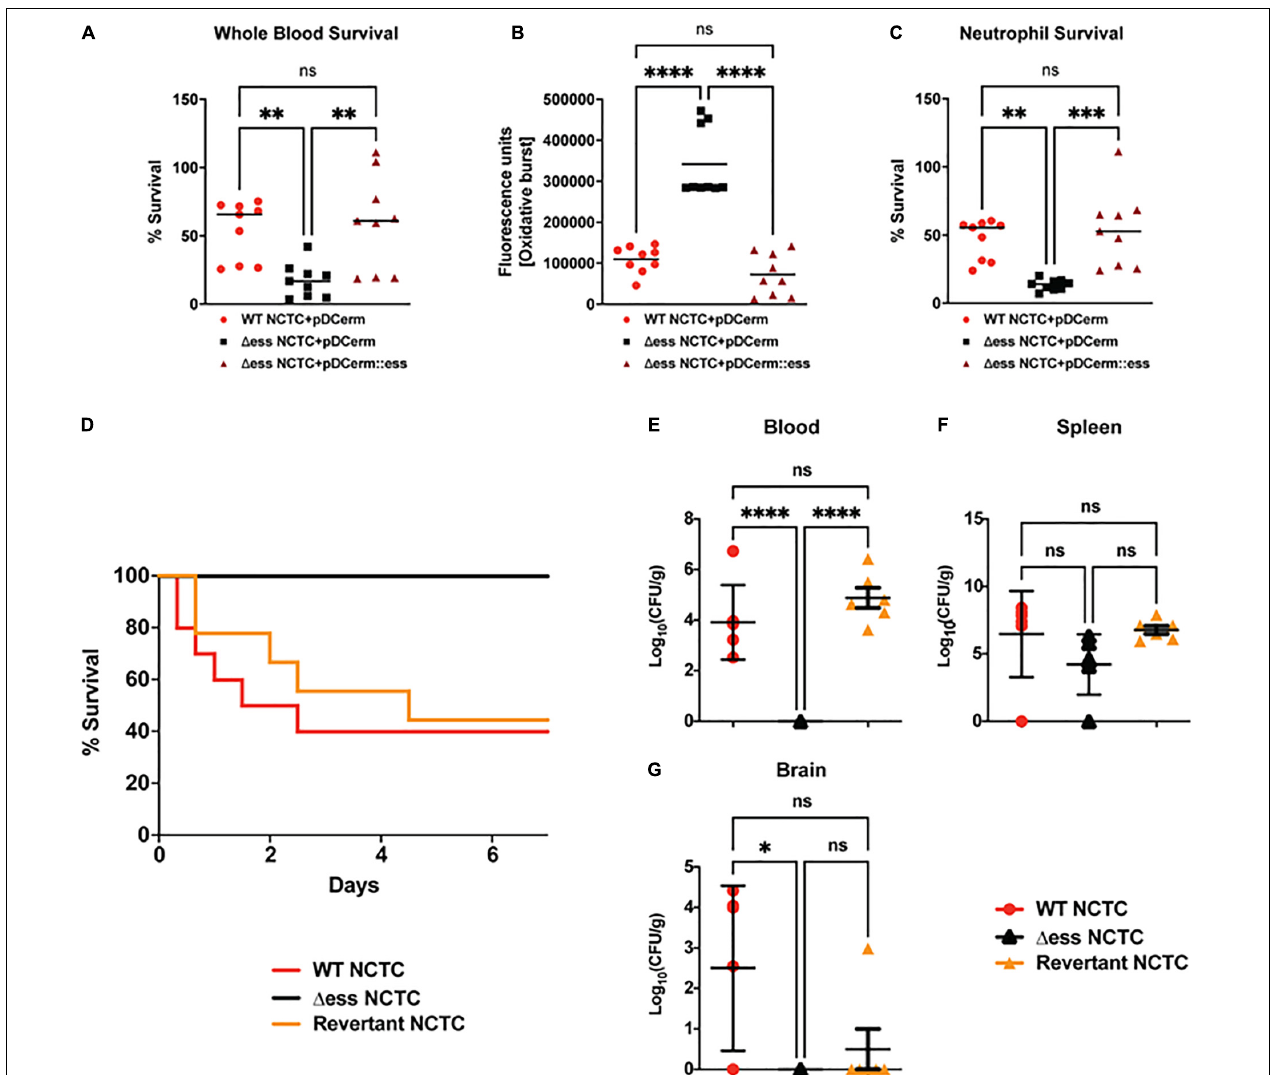
FIGURE 5 | GBS S protein is critical for GBS virulence in vitro and in vivo. (A) Whole blood survival assay results. Significance was determined using Tukey’s Multiple Comparisons Test ( ∗∗ p < 0.01). (B) Neutrophil oxidative burst assay results. Significance was determined using Tukey’s Multiple Comparisons Test ( ∗∗∗∗ p < 0.0001). (C) Bacterial survival following incubation with primary human neutrophils. Significance was determined using Tukey’s Multiple Comparisons Test ( ∗∗ p < 0.01; ∗∗∗ p < 0.001). (D) Kaplan-Meier plot demonstrating survival after I.P. challenge with GBS strains. (E) Bacterial CFUs recovered from blood 22 h post I.P. infection with GBS strains. Significance was determined using Tukey’s Multiple Comparisons Test ( ∗∗∗∗ p < 0.0001). (F) Bacterial CFUs recovered from spleen 22 h post I.P. infection with GBS strains. (G) Bacterial CFUs recovered from brains 22 h post I.P. infection with GBS strains. Significance was determined using Tukey’s Multiple Comparisons Test ( ∗ p <